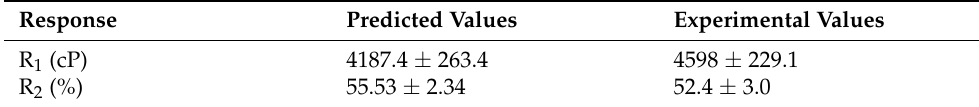
Table 3. Predicted and experimental value of response at optimized conditions.